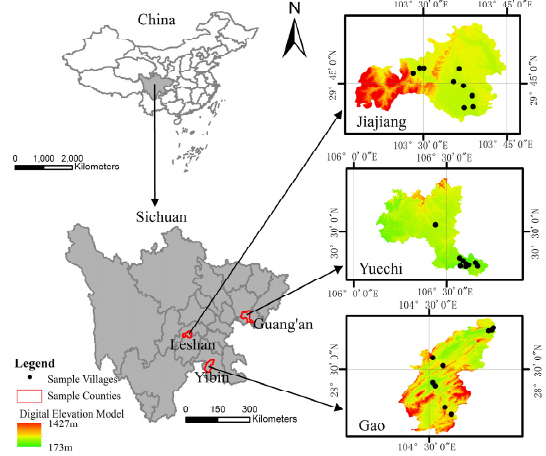
Figure 1. Spatial distribution map of the surveyed